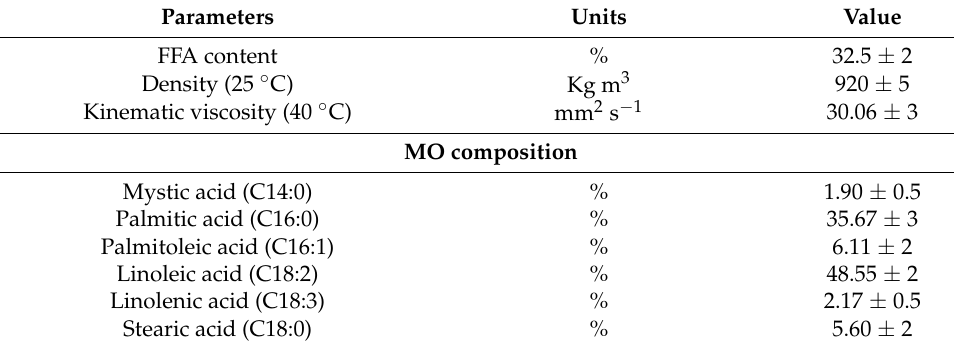
Table 1. Physicochemical properties of microalgae oil.